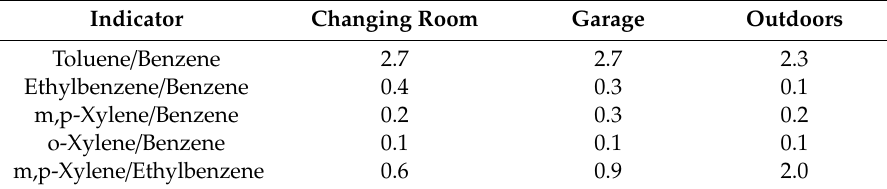
Table 3. Diagnostic indicators for the three sampling